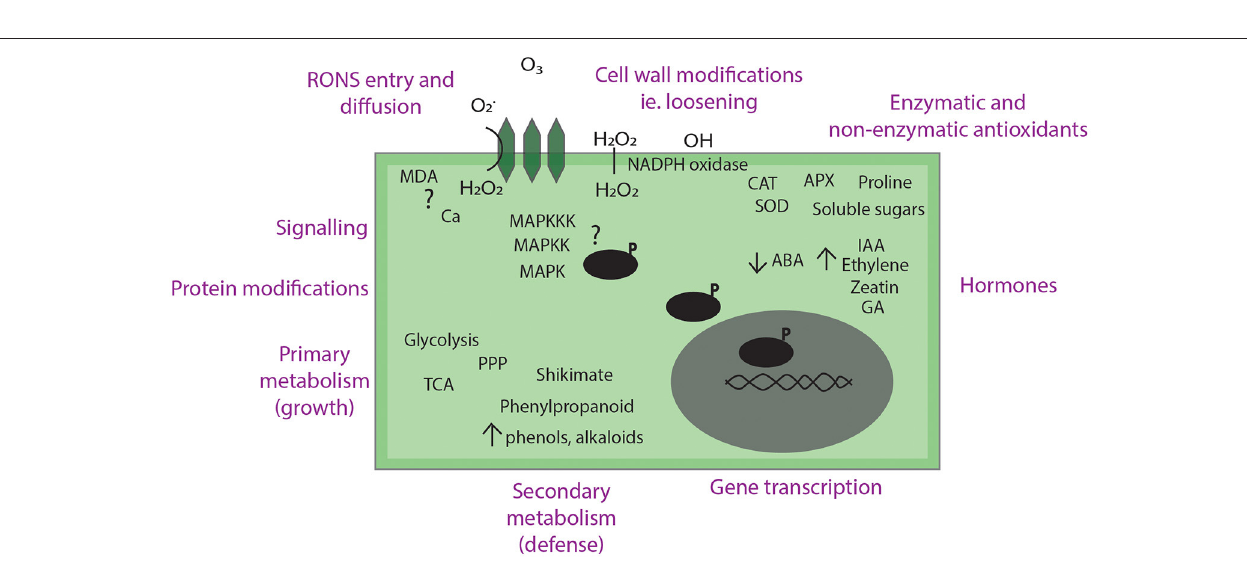
FIGURE 2 | Summary of the possible mechanical, chemical, and biochemical interactions of plasma components with the seed surface.